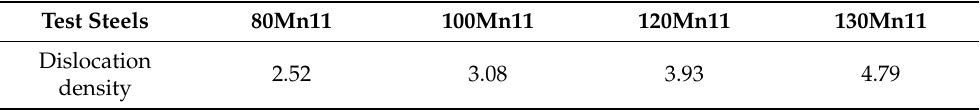
Figure 5. XRD patterns of test steels with different carbon content at a tensile strain of 0.2. Table 2. Dislocation densities of test steels with different carbon content at a tensile strain of 0.2 ( × 10 15 · m − 2